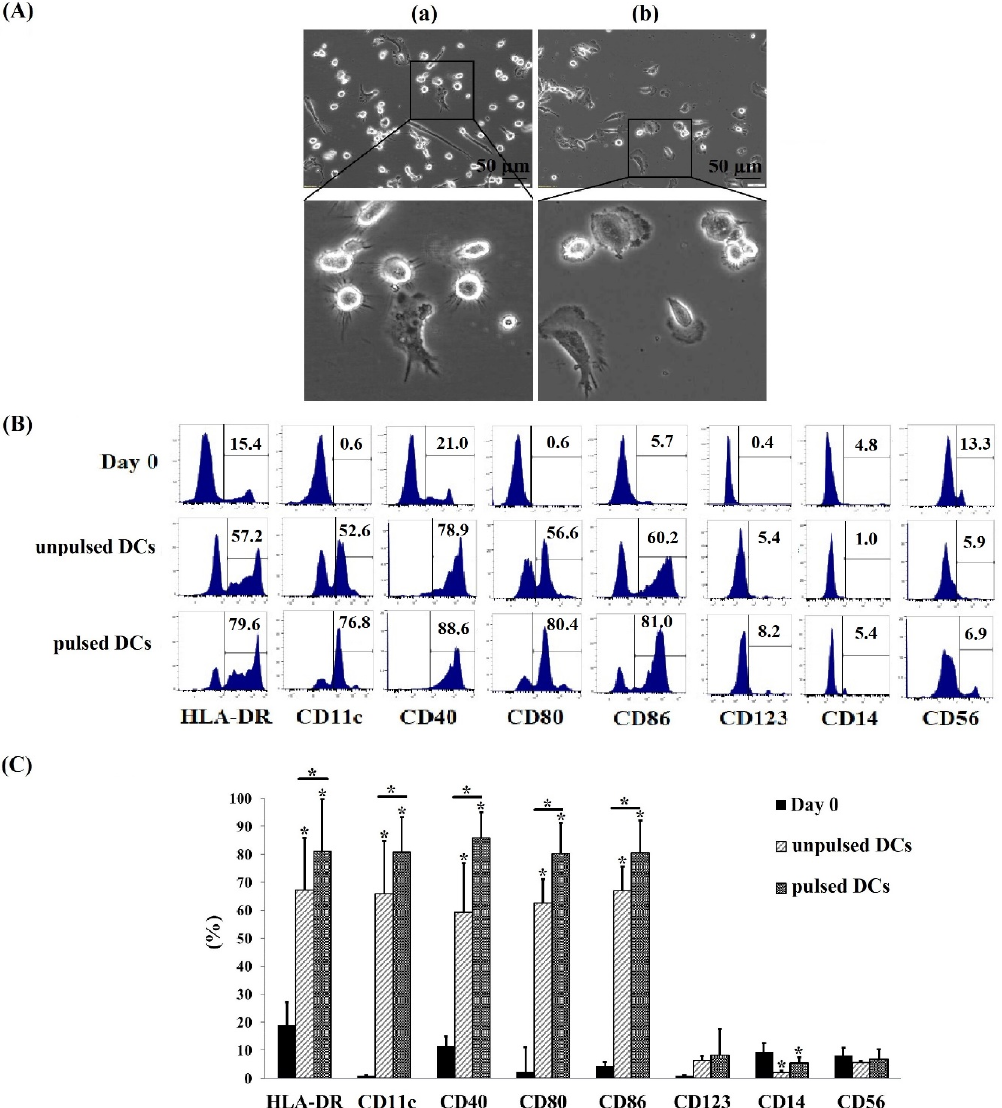
percentage of cells expressing DC markers was significant higher in pulsed DCs when compared to unpulsed ones ( p < 0.05). The pulsed DC population expressed DC markers were high on most cell culture such as HLA ‐ DR: 81.0 ± 18.7%, CD11c: 80.9 ± 12.4%, CD80: 80.4 ± 29.1%, CD40: 85.9 ± 9.1%, and CD86: 80.6 ± 16.8% (Figure 1C). This indicated that mature DCs have been generated successfully from cryo CBMCs.